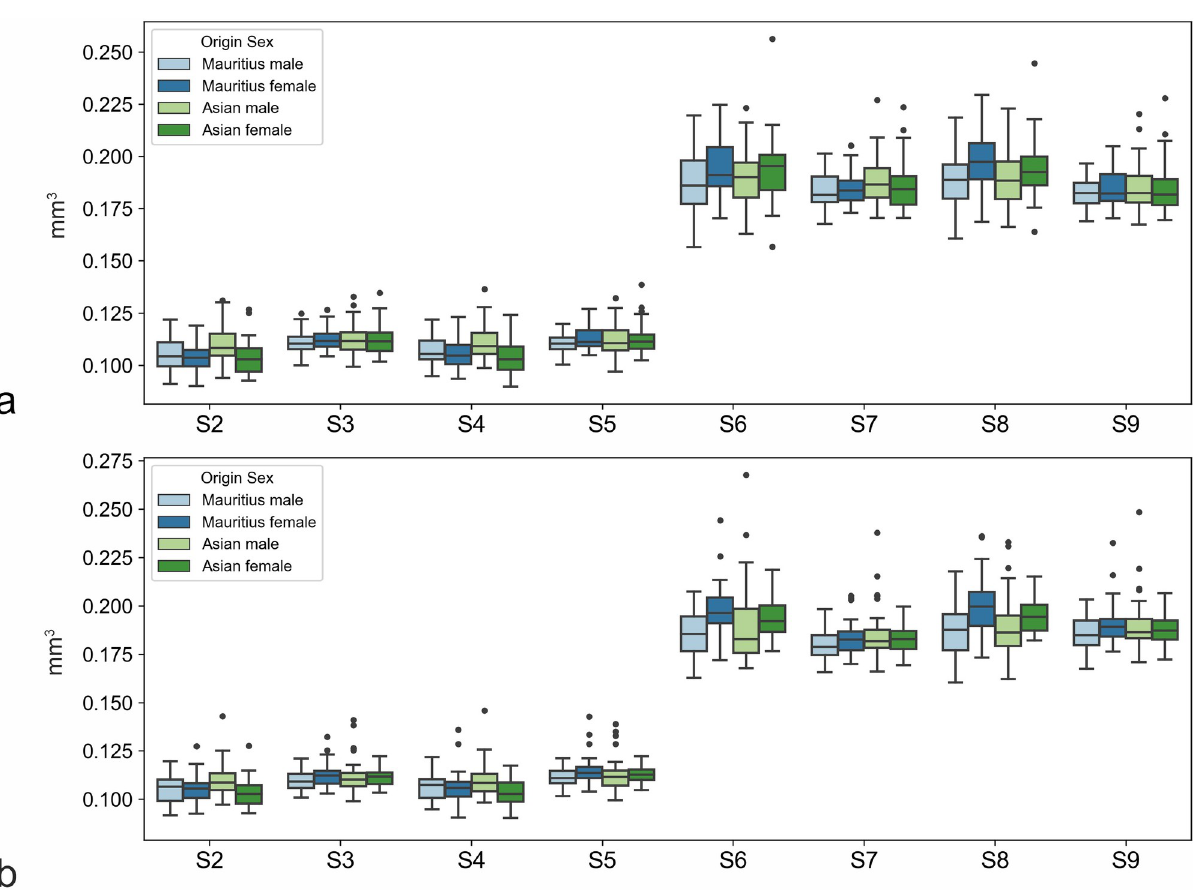
Fig 4. Boxplots of origin-specific variations in choroid volumes. For right ( 4a , OD) and left eyes ( 4b , OS) measured as slices.